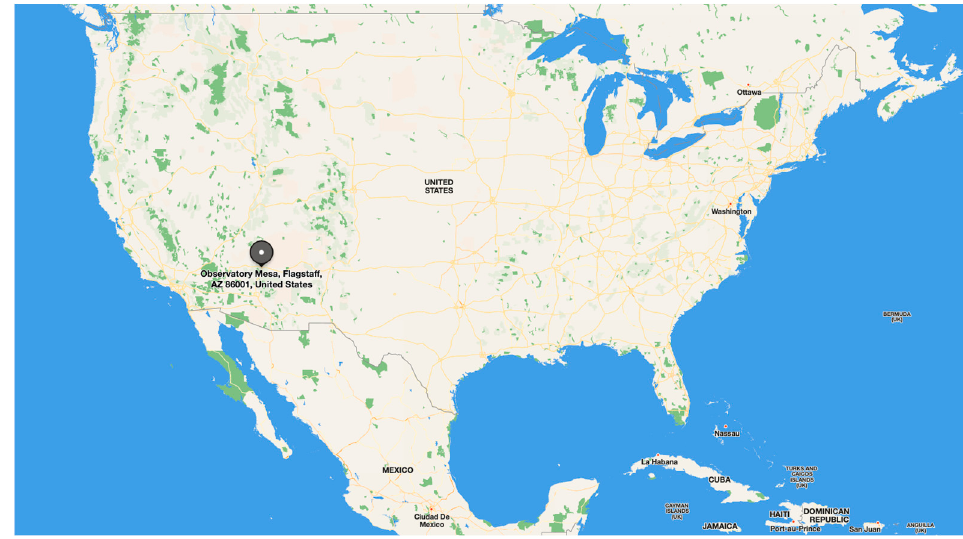
Figure 4. The FLAME is collected in Flagstaff, Arizona, USA, Ponderosa pine forest on Observatory Mesa.